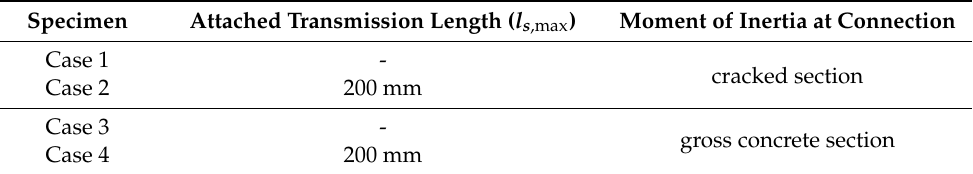
Table 3. Analysis Table 3. Analysis conditions.